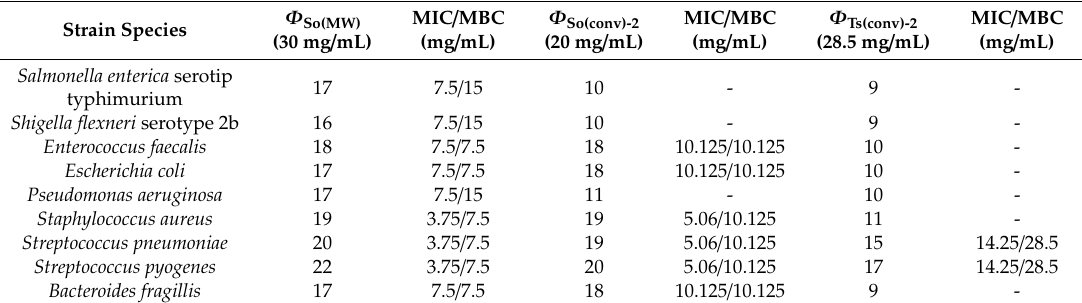
Table 4. Antimicrobial activity of polyphenolic